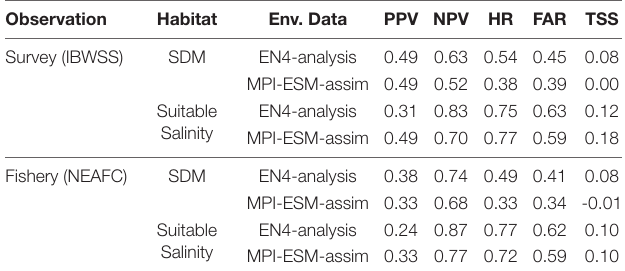
TABLE 4 | Agreement of the suitable spawning habitat with independent observations of adult blue whiting observed in the IBWSS survey and caught in fishery (NEAFC) during March and April within the spawning